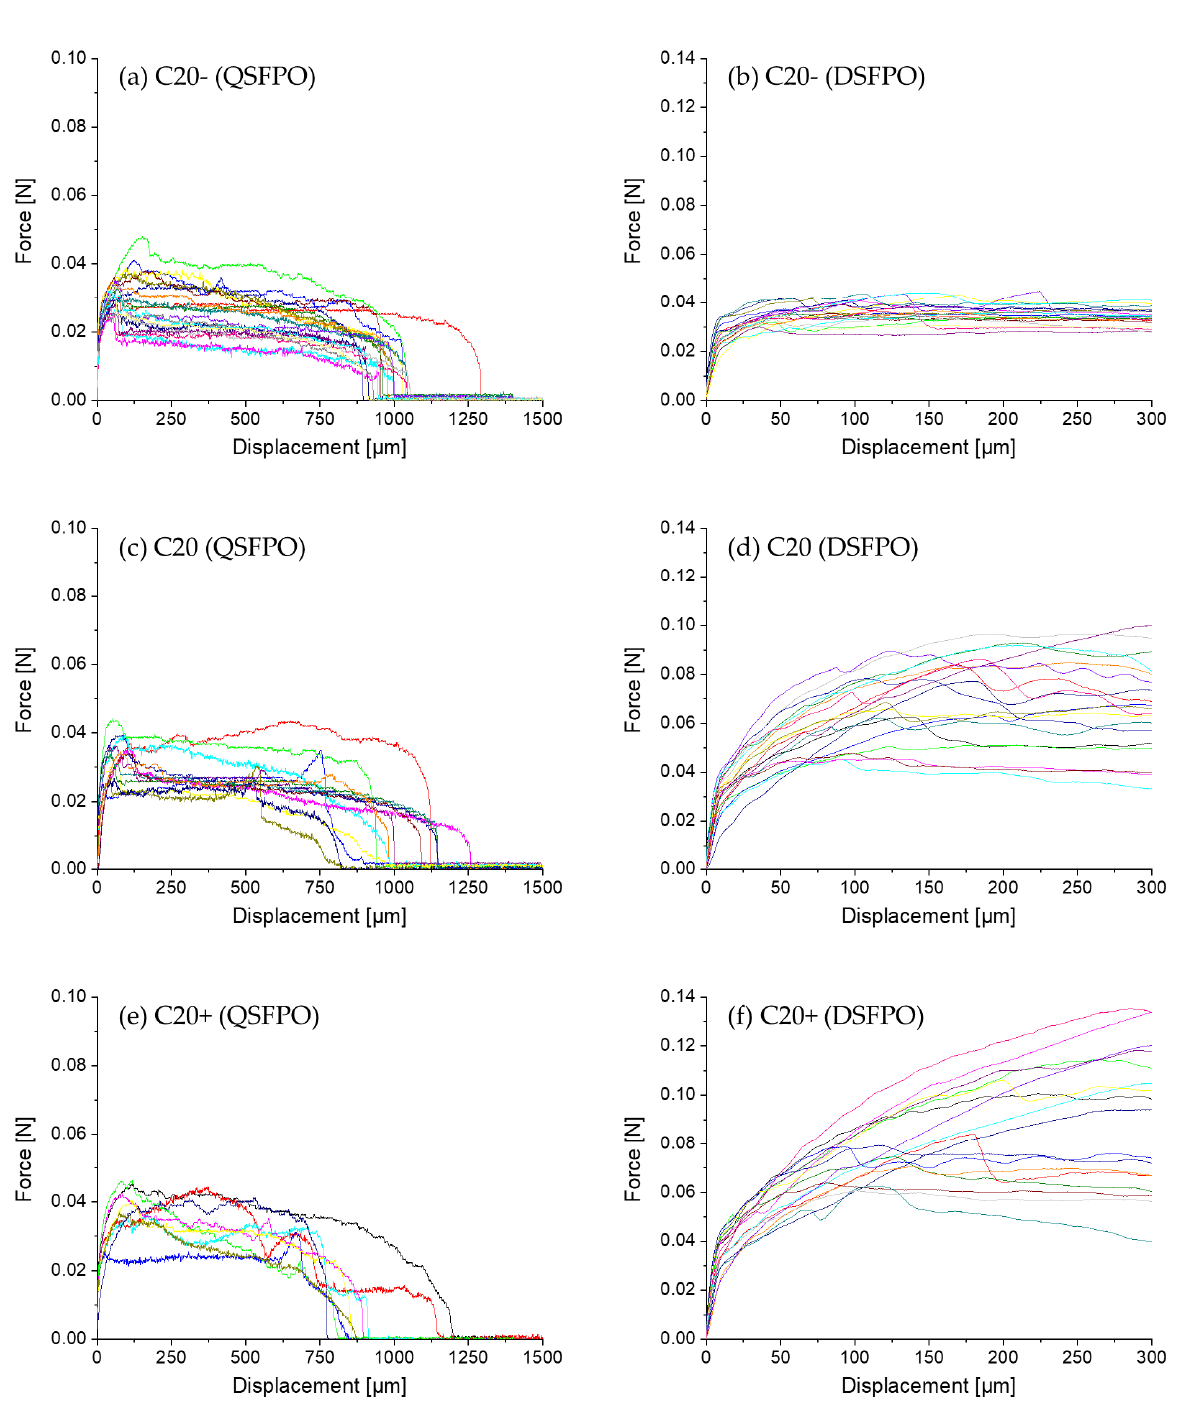
Figure 8. Force–displacement curves recorded during single-fiber pull-out of ( a , c , e ) circular C20 − , C20, and C20+ fibers embedded in high-strength concrete matrix under quasi-static and ( b , d , f ) dynamic loading. Note the different axes’ limits. Color lines indicate different test